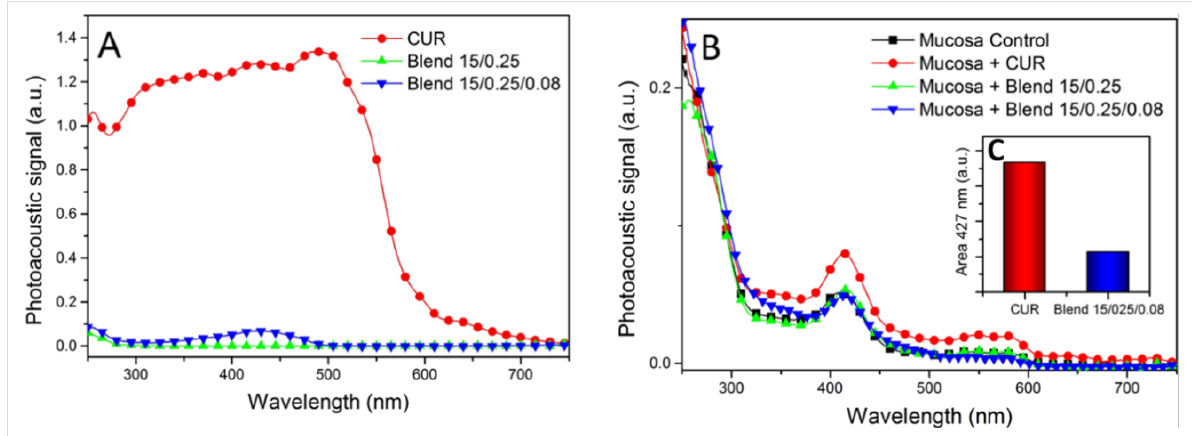
Figure 11: Optical absorption spectra obtained from PAS with (A) CUR and polymeric systems with and without CUR, (B) permeation of CUR through mucosa and (C) area of behavior of permeation of absorption band in 427 nm in mucosa.